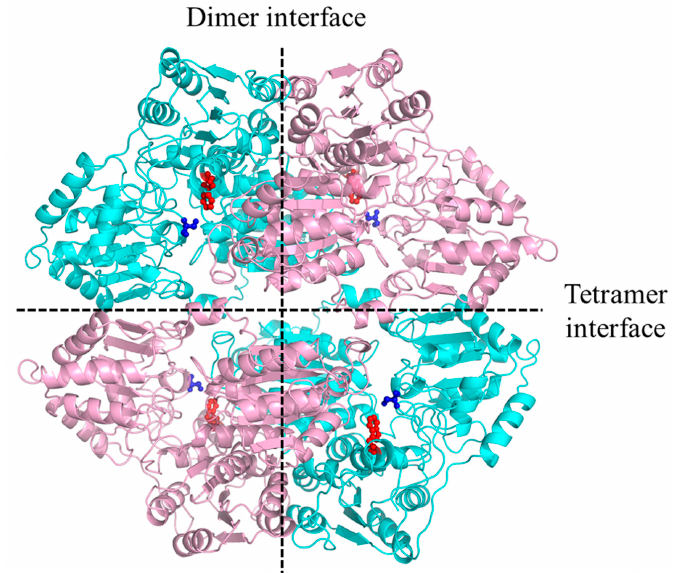
Figure 9. The W548 location in the AHAS-WT tetramer. The interfaces were labeled by dash Lines. The backbone of the monomer was colored as pink and cyan, respectively. W548 was shown as a red stick-ball model, S627 was shown as a blue stick-ball model.